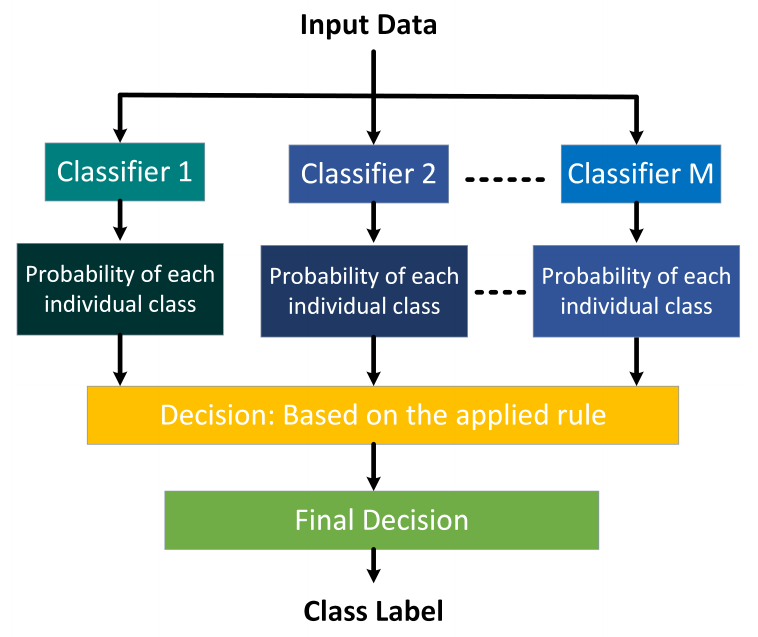
Figure 6. Ensemble classifier based on a soft-level